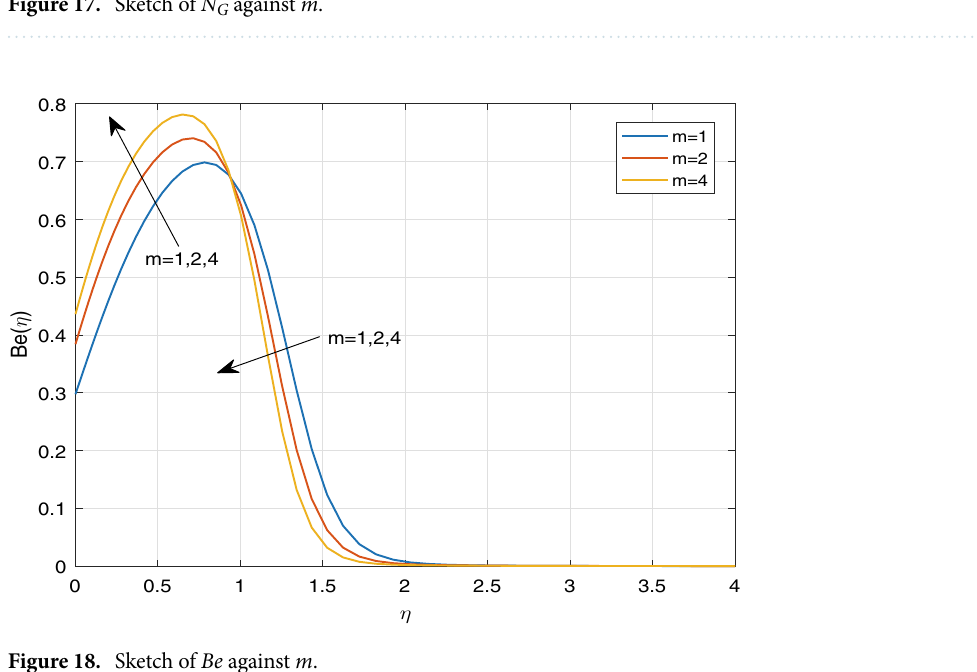
Figure 18. Sketch of Be against m